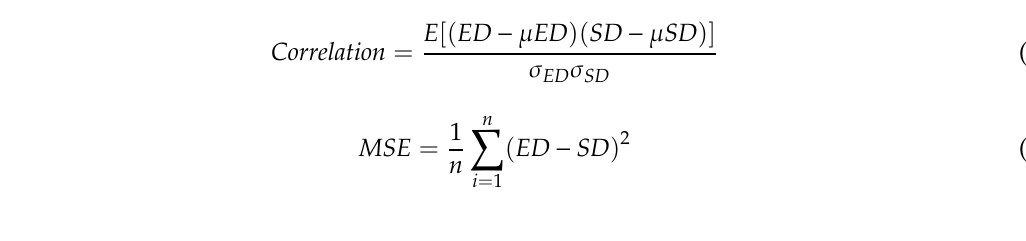
Table 1. Comparison of statistical fit functions with experimental